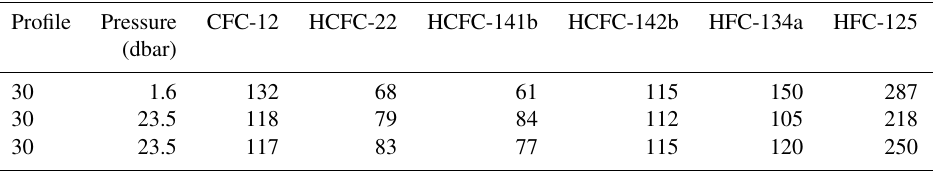
Table 3. Seawater surface saturations (%) of CFC-12, HCFC-22, HCFC-141b, HCFC-142b, HFC-134a, and HFC-125 in profile 30 from cruise AL516 (measured by the Medusa–Aqua system) in the Baltic Sea.